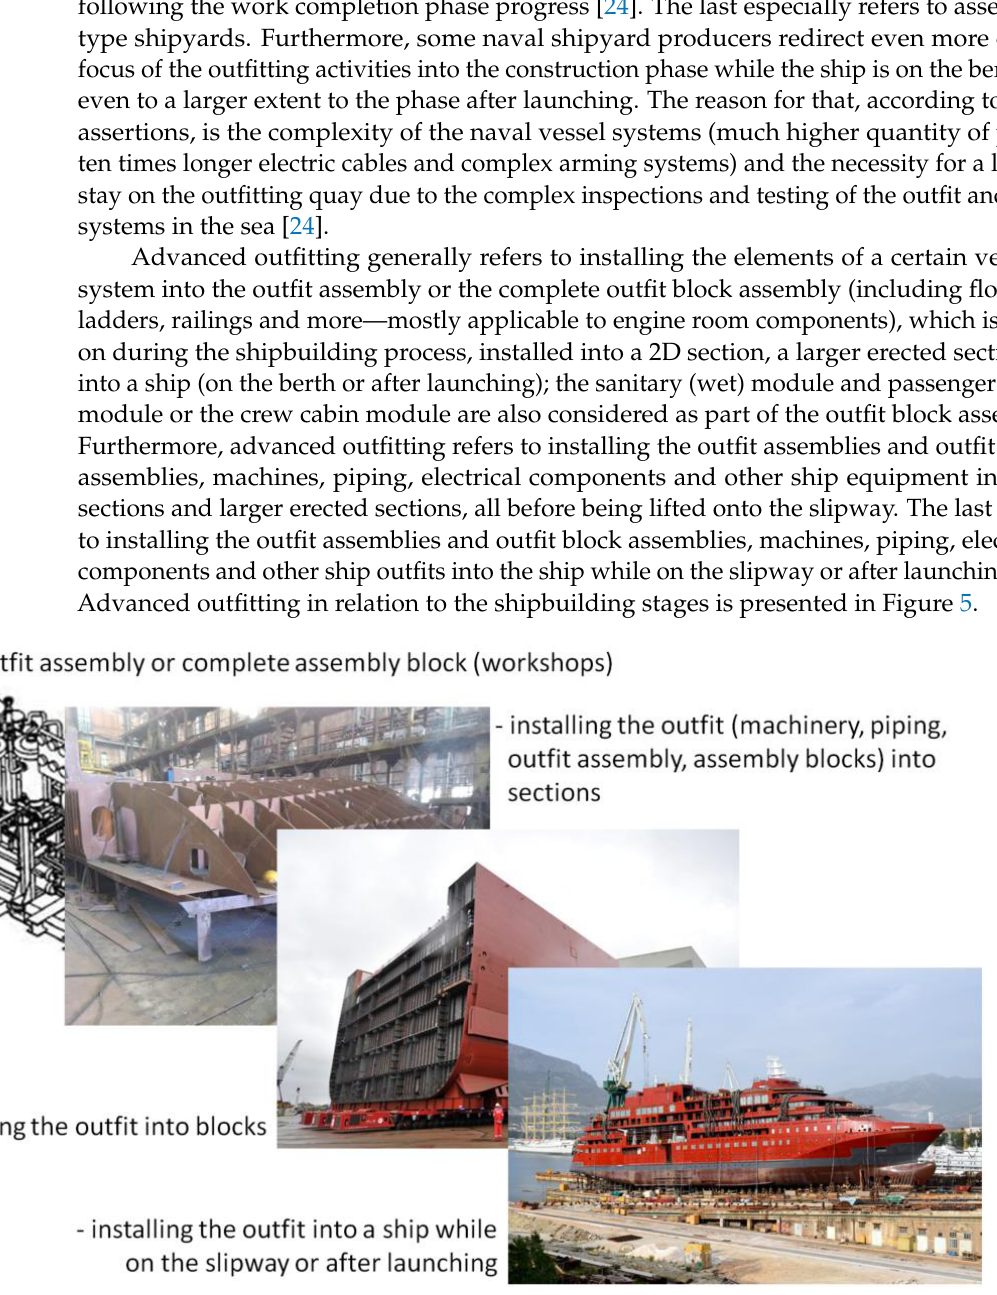
Figure 5. Advanced outfitting in relation to the shipbuilding stages.